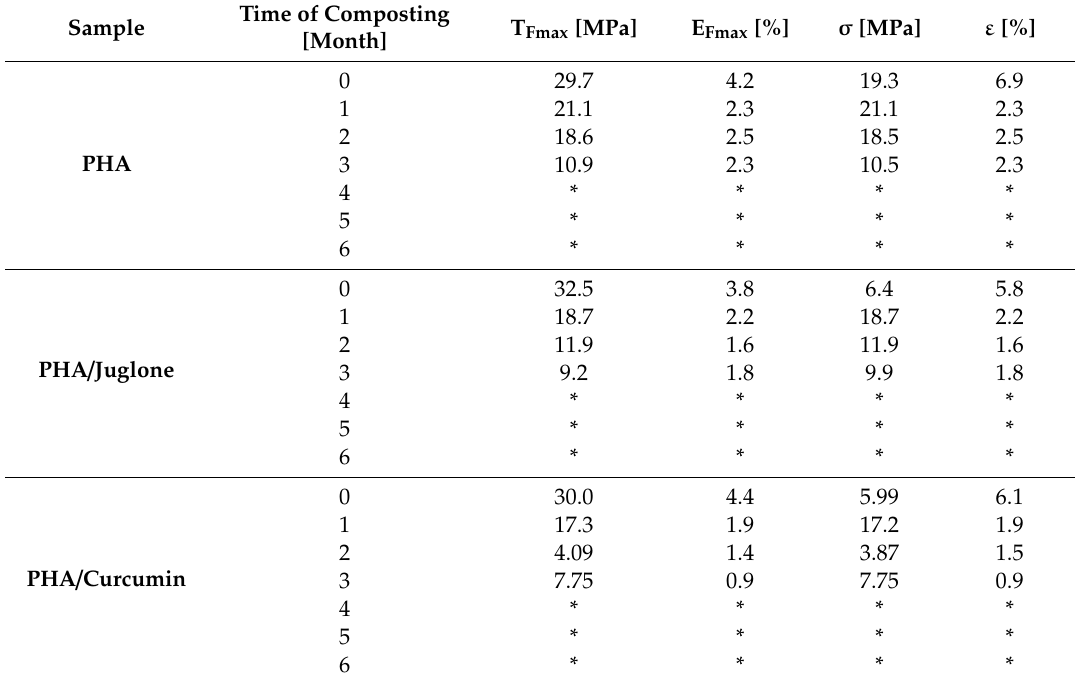
Table 4. Mechanical properties of PHA-based samples over 6 months of composting (T Fmax the maximum stress transferred by the sample [MPa], E Fmax the elongation at break for maximum tensile stress [%], σ the tensile strength [MPa], and ε the total elongation at break [%]). Time of Sample